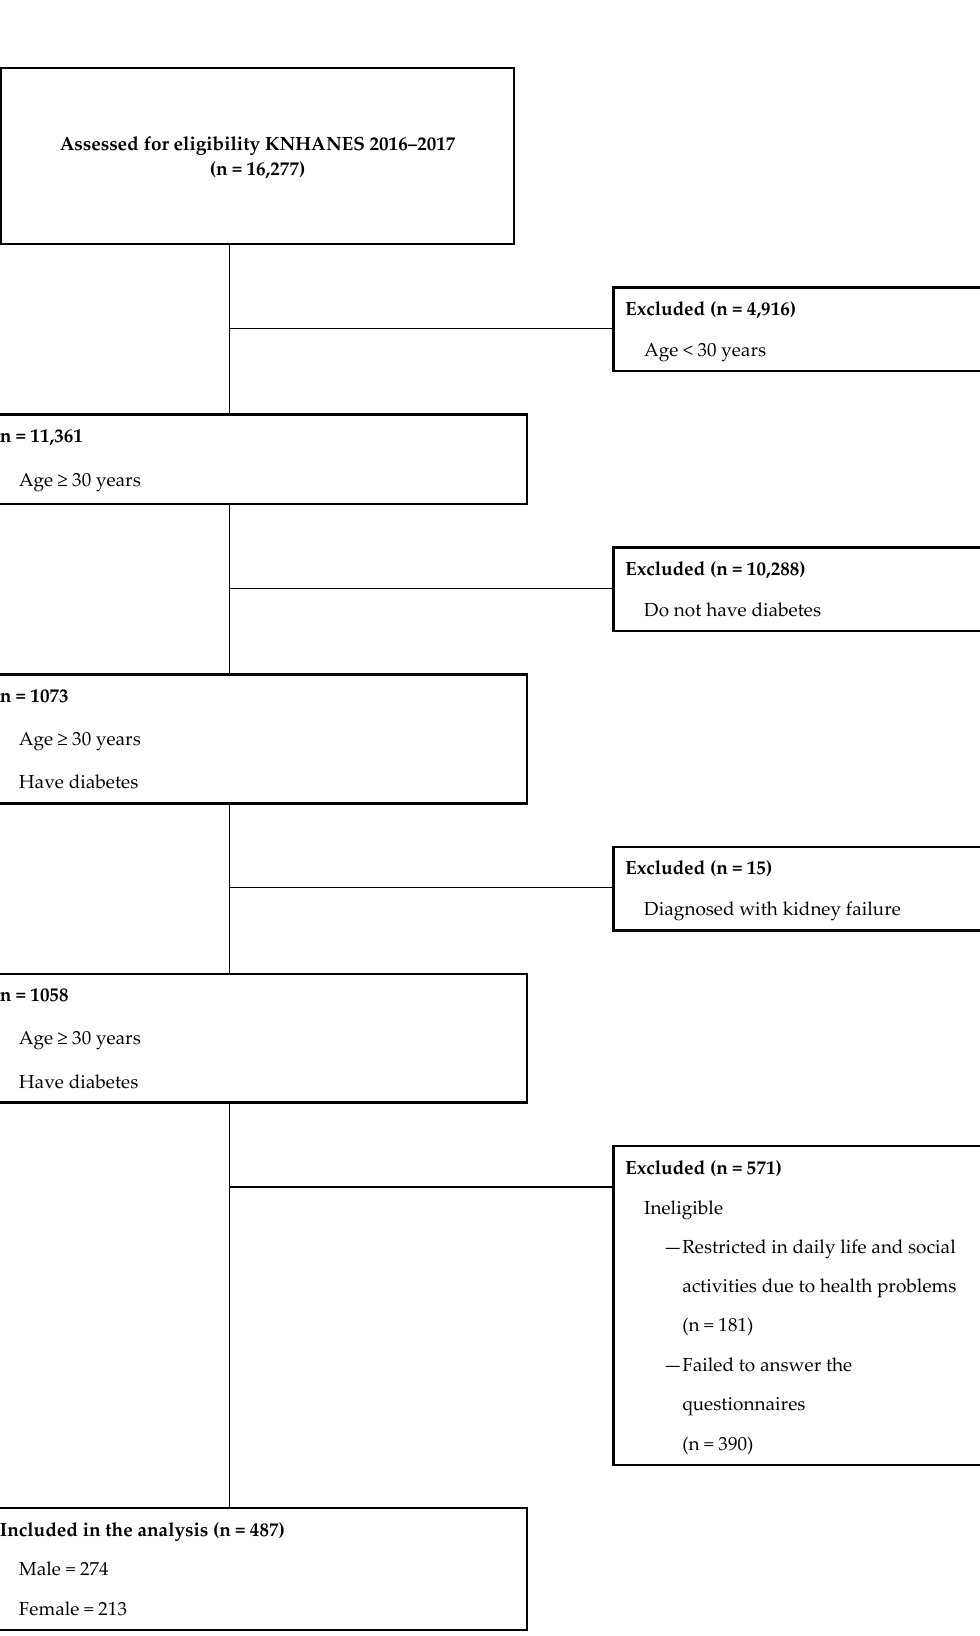
Figure 1. Flow diagram of subject inclusion and exclusion.